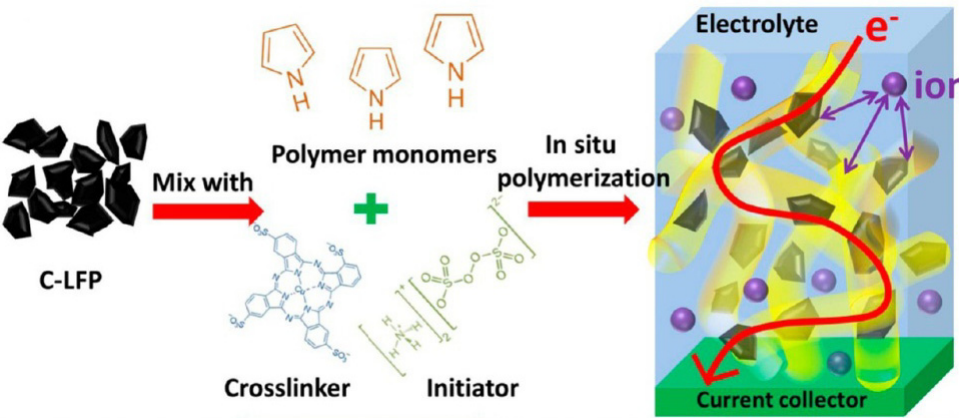
Figure 6. Schematic of synthetic and structural features of C-LFP/C-PPy hybrid gel framework [83]. Reprint with permission from [83]; Copyright 2017, American Chemical Society.